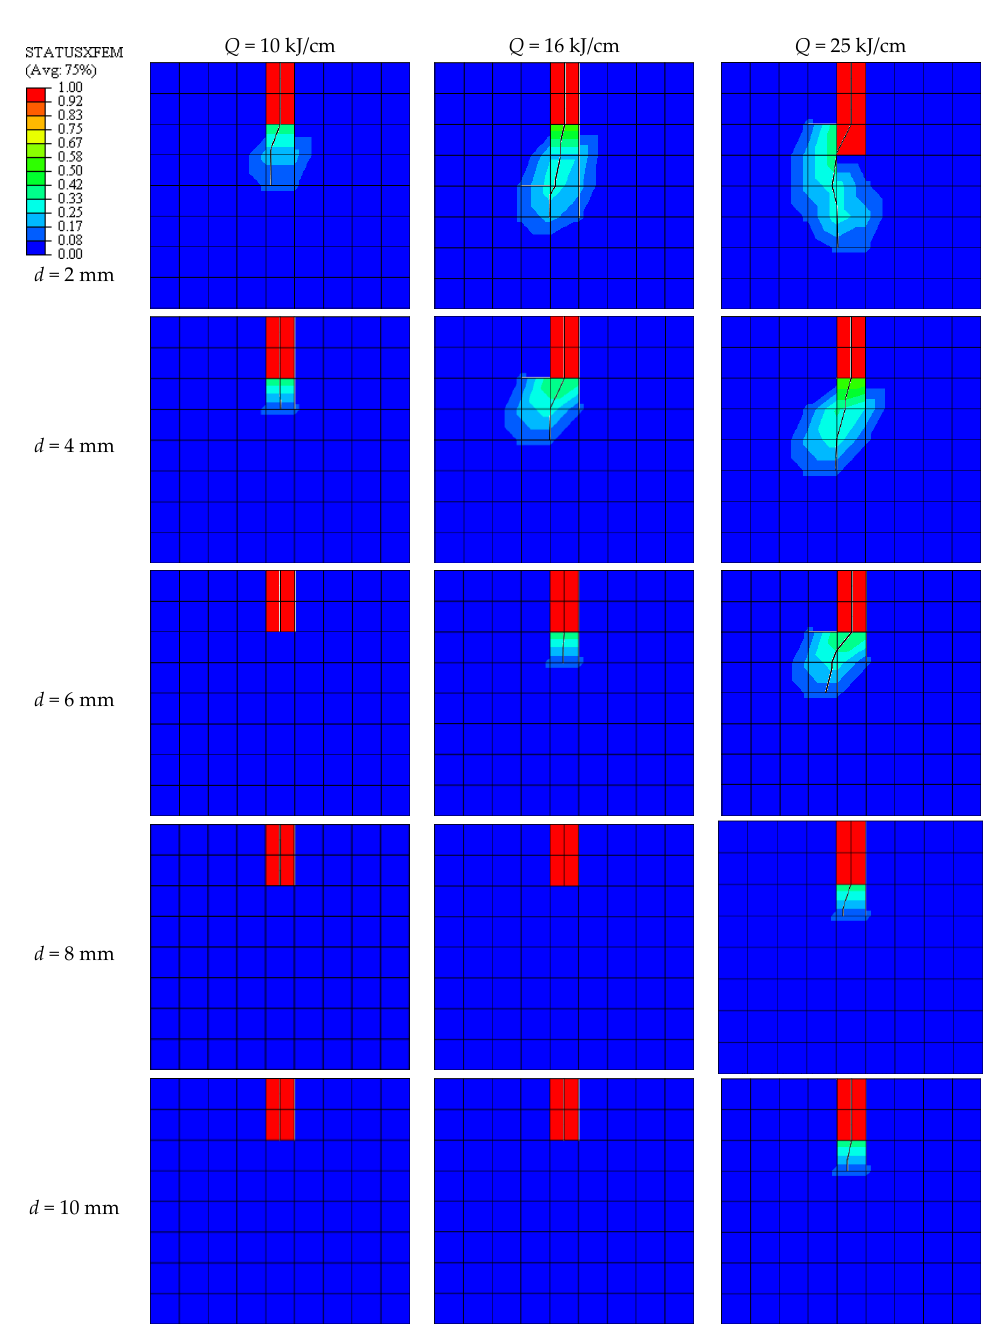
Figure 23. Crack propagation predicted by XFEM at different positions for three different linear energy values.